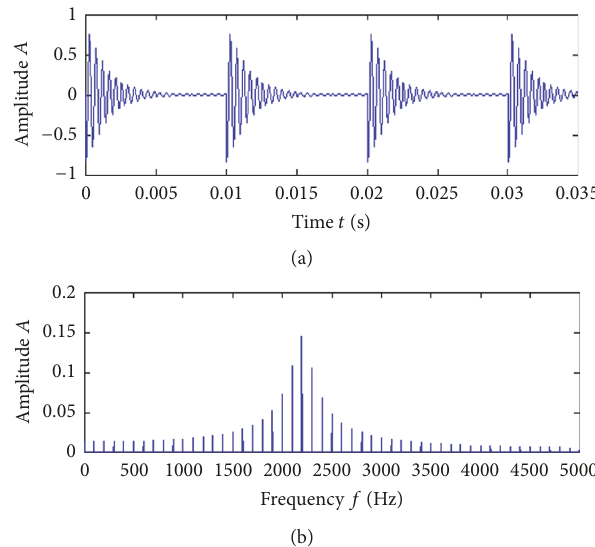
Figure 2: Simulated bearing fault signal: (a) time domain waveform and (b) FFT spectrum.